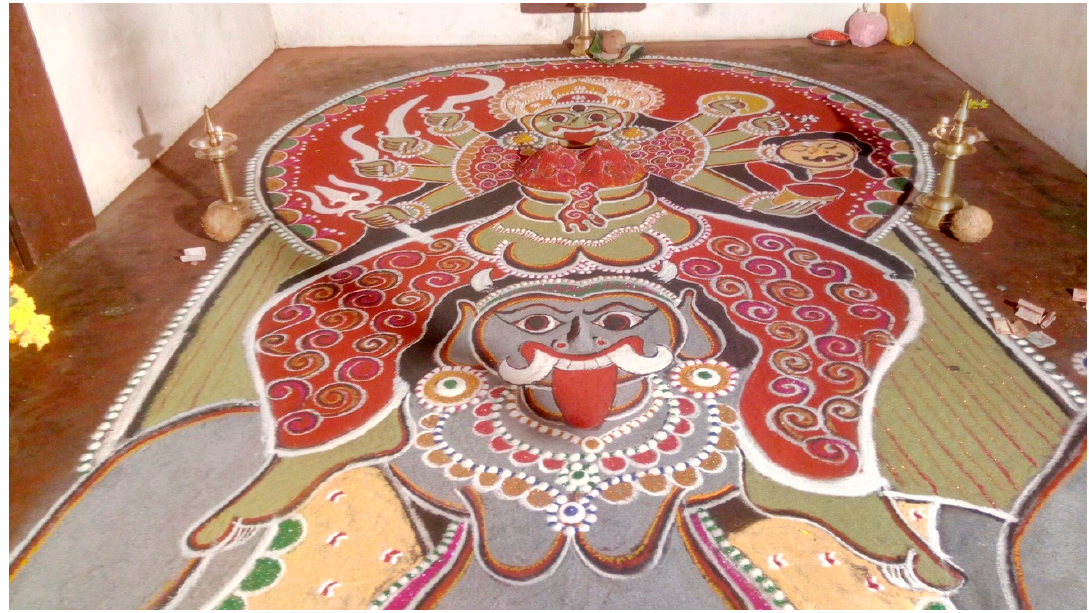
Figure 4. ka ḷ am drawn prior to a mu ṭ iy ē ṯṯ u’ performance representing Bhadrak ā ḷ i with eight hands am drawn prior to a mut.iy¯et t u’ performance representing Bhadrak¯al Figure 4. kal ¯ ¯ ˙ holding weapons and riding on V ē t ā ḷ am (Photo by Thirumarayur Vijayan Marar). holding weapons and riding on V¯et¯al am (Photo by Thirumarayur Vijayan ˙